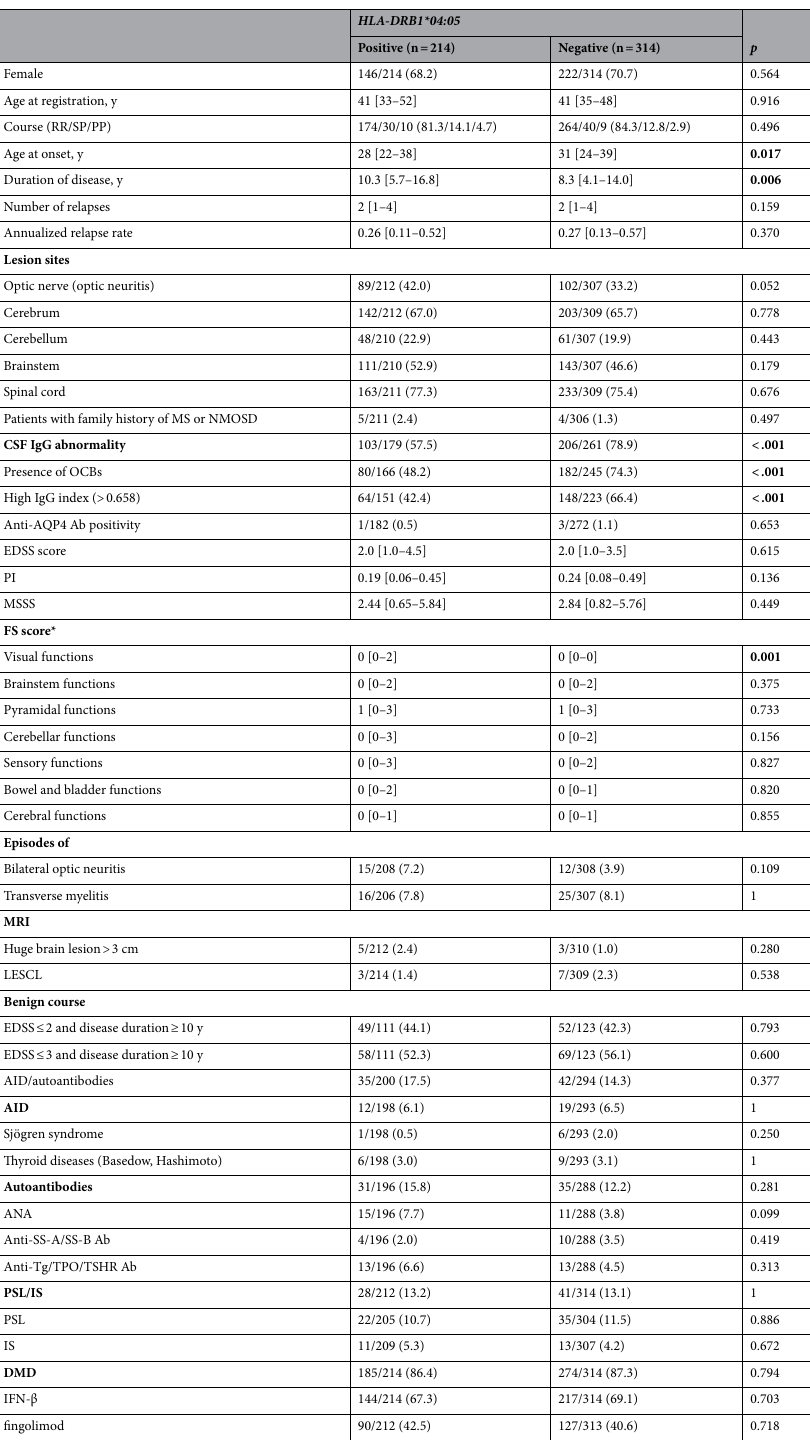
Table 6. Comparison of the clinical characteristics between MS patients with and without HLA-DRB1*04:05 . Bold values indicate significant differences. Values are median [interquartile ranges] or count (%). Ab , antibody, AID autoimmune disease, ANA , anti-nuclear antibody, AQP4 aquaporin 4, CSF cerebrospinal fluid, EDSS , expanded disability status scale, FS functional system, IFN interferon, IS immunosuppressants, LESCL longitudinally extensive spinal cord lesion, MS multiple sclerosis, MSSS multiple sclerosis severity score, NMOSD neuromyelitis optica spectrum disorders, OCBs oligoclonal IgG bands, PI Progression Index, PP primary progressive, PSL prednisolone, RR , relapsing–remitting, SP secondary progressive, Tg thyroglobulin, TPO thyroid peroxidase, TSHR thyroid stimulating hormone receptor, y years. *In the section of functional system scores, values are median [10-90th